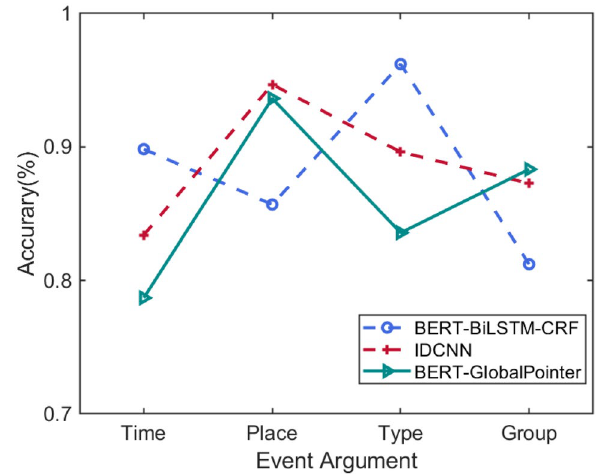
Fig. 5 Results of EAE